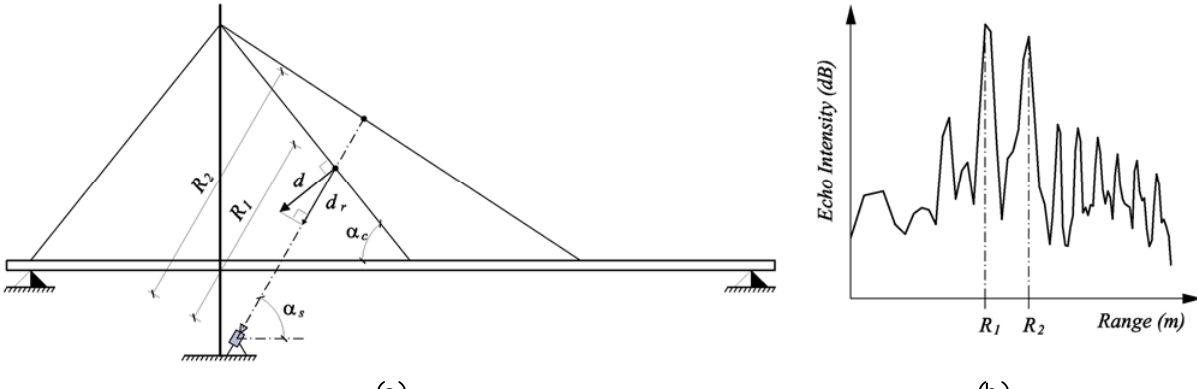
Figure 2. (a) Line-of-sight displacement versus actual (in-plane) displacement of a stay-cable, and (b) typical range profile expected for an array including two